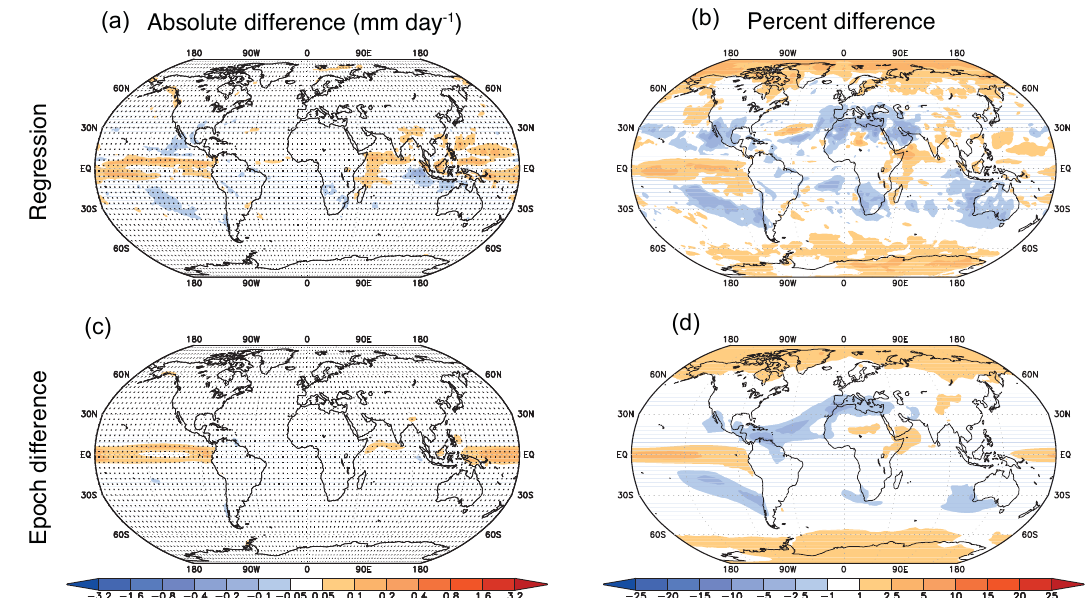
Figure 3. Differences between the reconstructions produced by pattern scaling ( ˆ B ) and the actual model output for precipitation ( B ). (a) shows absolute values of ˆ B − B (mmday − 1 ), and (b) shows percent change. Top row shows results for the regression method, and bottom row shows the epoch-difference method. All values are calculated for a group 1 multi-model average for the 1pctCO2 simulation over the years 116–140. Stippling indicates a lack of statistical significance in the pattern of differences (Sect.